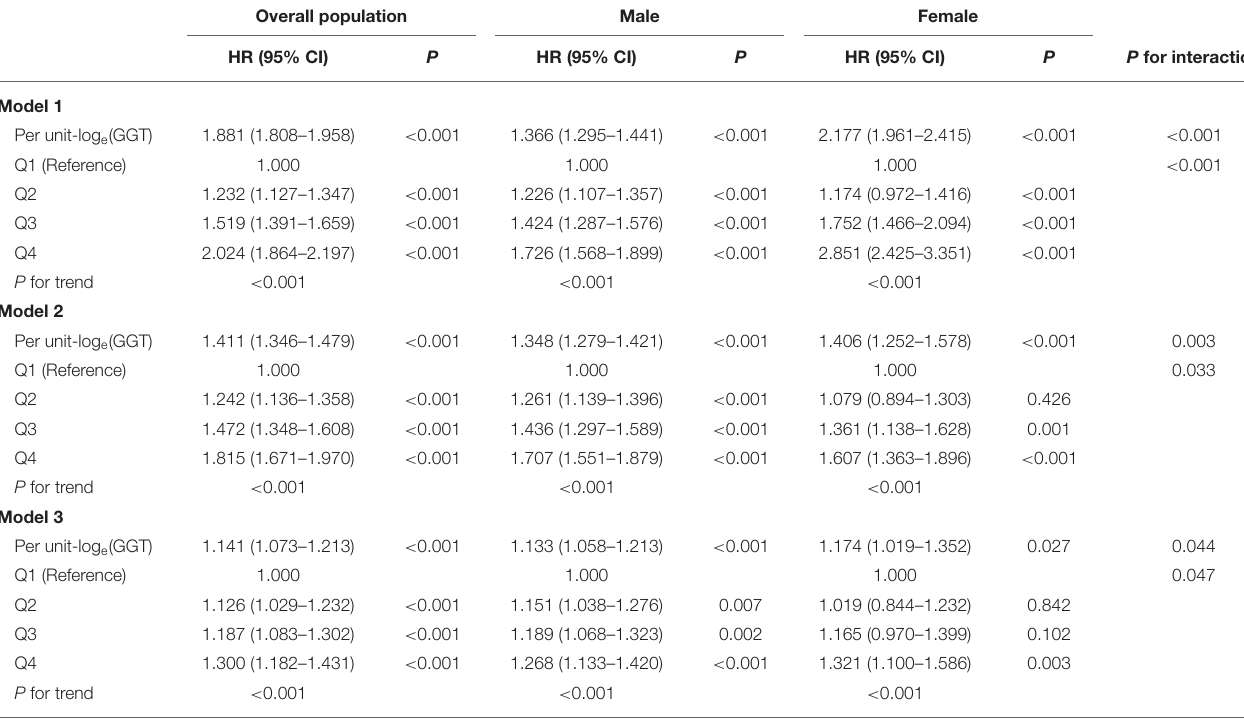
TABLE 2 | Risk of incident hypertension according to baseline serum gamma-glutamyltransferase quartiles. Overall population